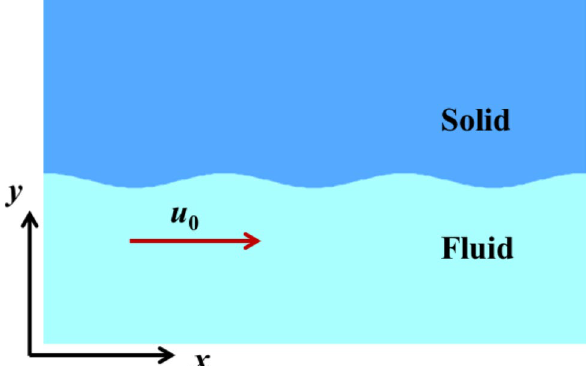
Figure 2. The material interface at initial